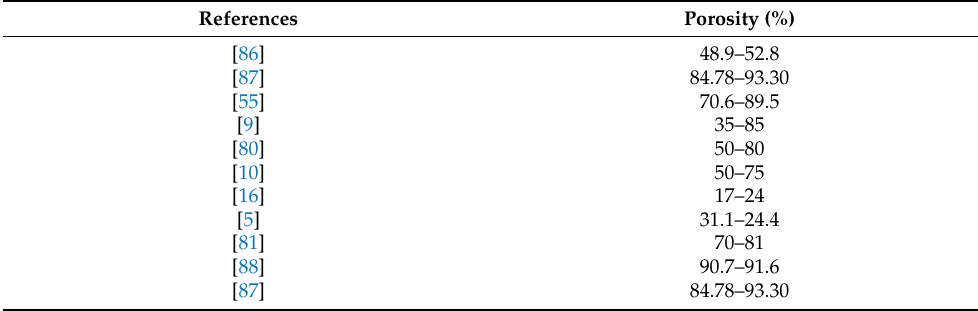
Table 7. The porosity percentages of different